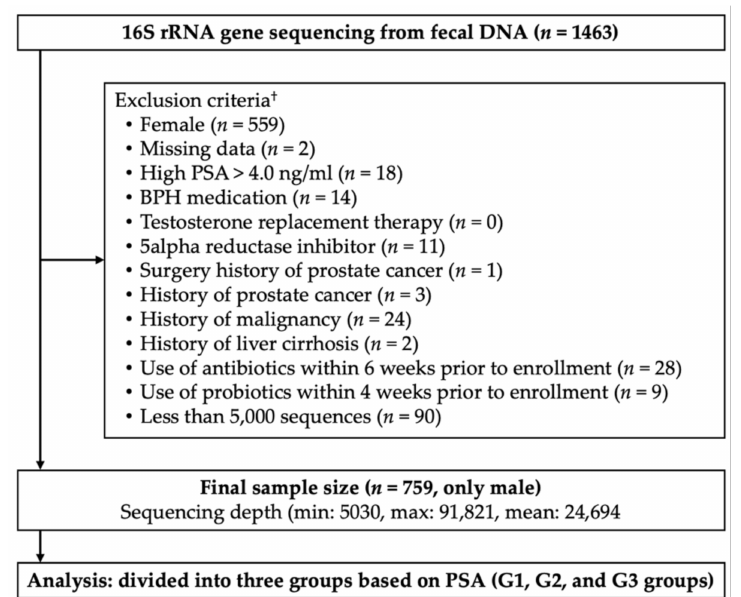
Figure 1. Enrollment of subjects. G1, lowest quartile (<25 percentile of the PSA range); G2, interquar- tile (from 25 percentile to 75 percentile of the PSA range); G3, highest quartile (>75 percentile of the PSA range). † Some subjects met several exclusion